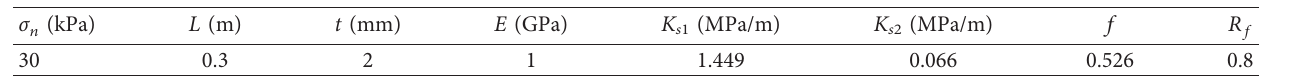
Figure 11: The relationship between the normal stress and shear stiffness of the hardening model: (a) shear stiffness; (b) initial shear stress. Table 4: Hardening model